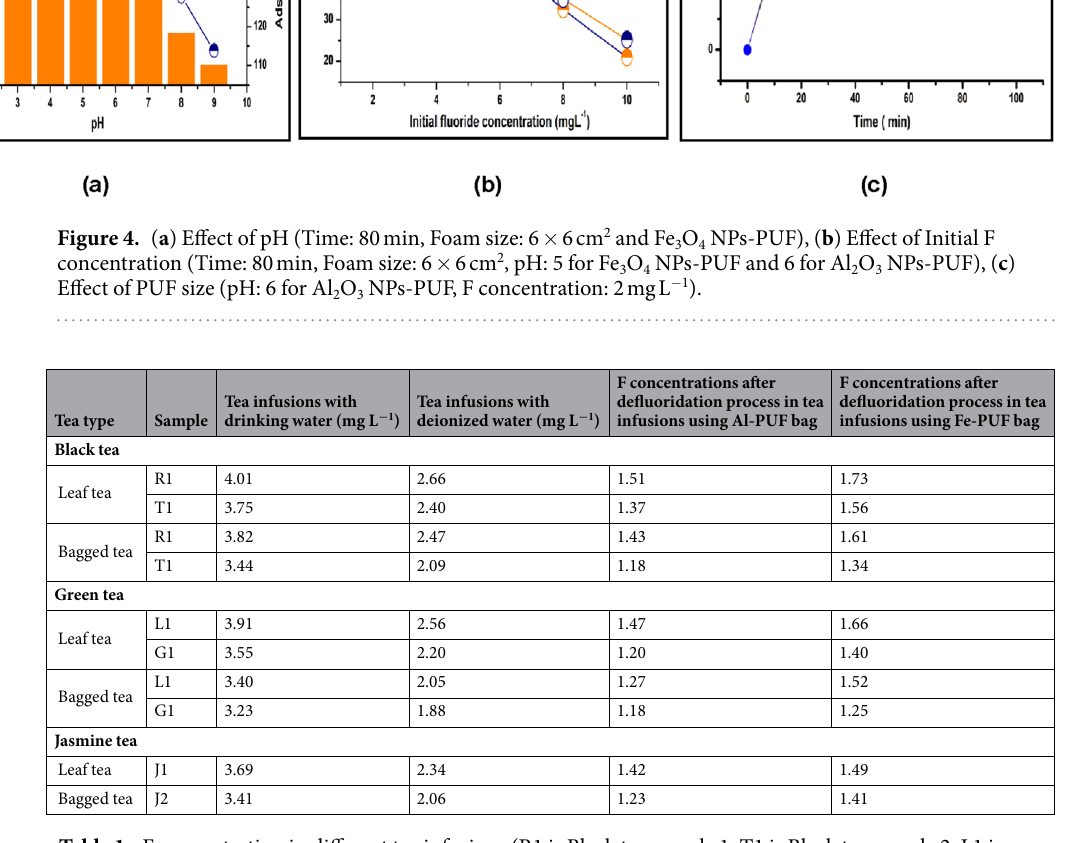
Table 1. F concentration in different tea infusions (R1 is Black tea sample 1, T1 is Black tea sample 2, L1 is Green tea sample 1, G1 is Green tea sample 2, J1 is Jasmine tea sample 1, J2 is Jasmine tea sample